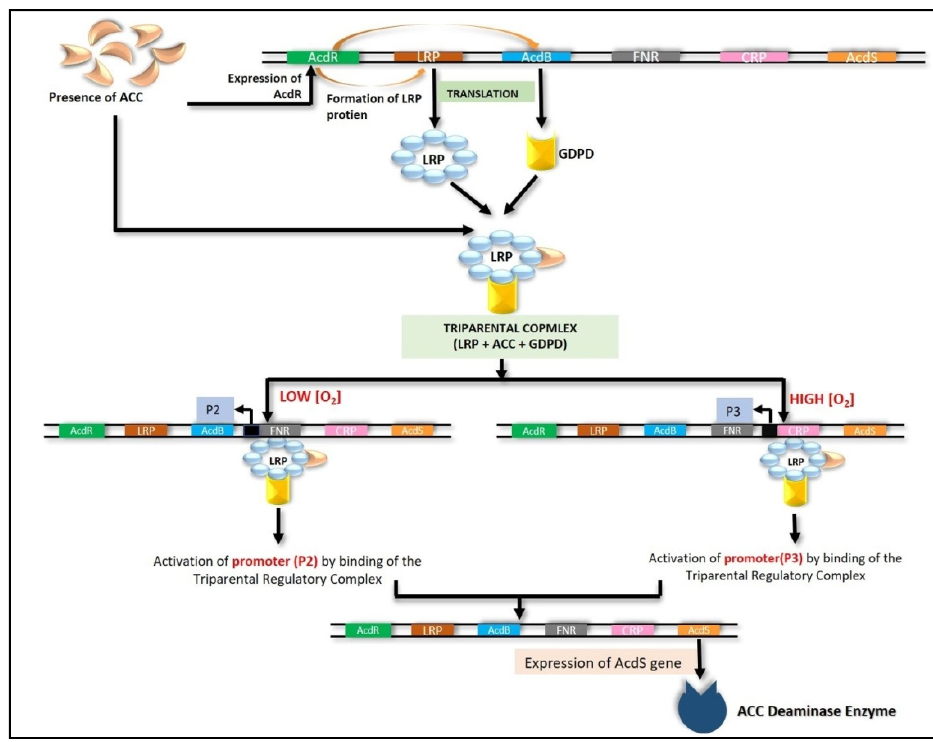
Figure 6. Transcriptional regulation of acdS gene by the action of octameric LRP protein.